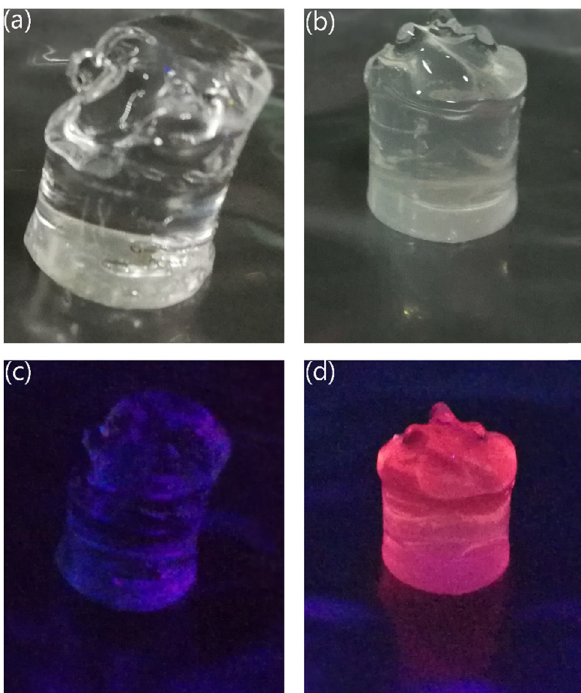
Figure 8: The emission spectrum of the composite gel excited by X -